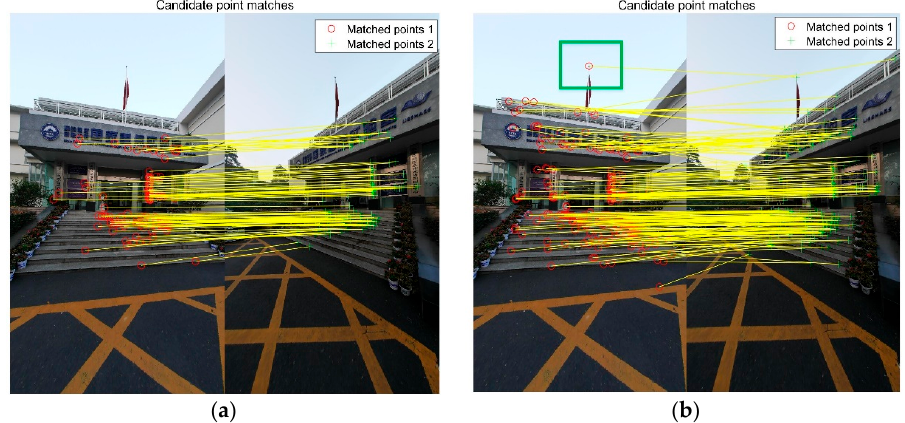
Figure 2. Comparison between the F matrix and E matrix in geometry check. ( a ) RANSAC and